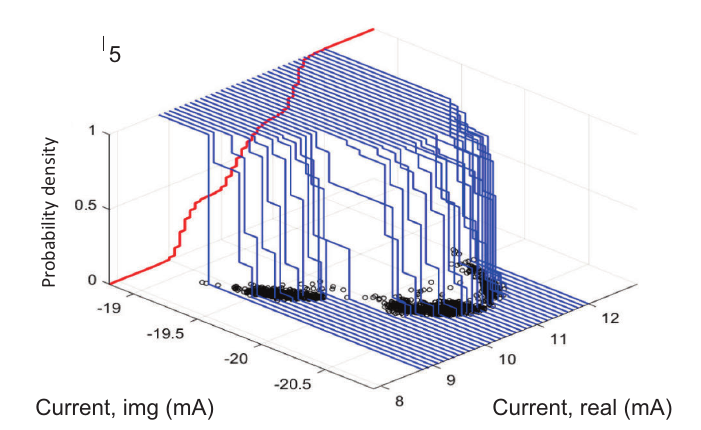
7.png Fig. 9. EBPD applied to the 5th harmonic of the PC under stress test